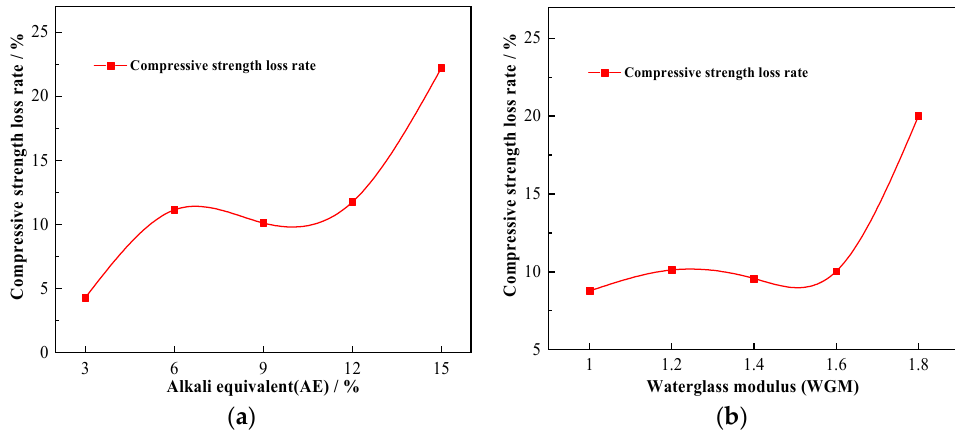
Figure 6. Compressive loss rate of GPM after 270 d of seawater immersion: ( a ) The impact of AE; ( b ) The impact of WGM.